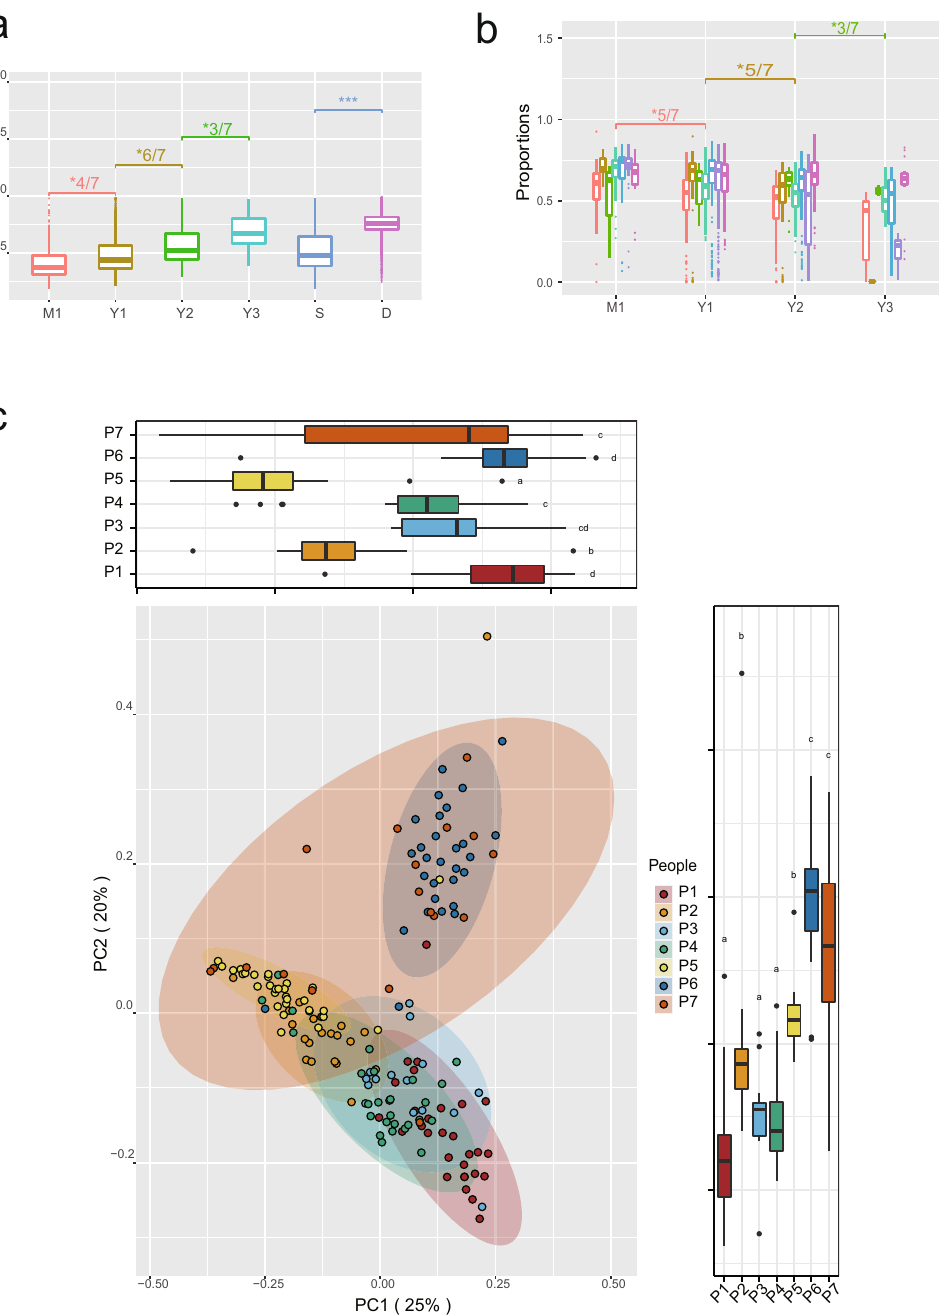
Fig. 2 Sample comparsions for gut microbiota composition. a Boxplots showing the Bray – Curtis dissimilarities between samples from four groups (M1/ Y1/Y2/Y3). M1 denotes comparisons from the same subject collected within a short time interval (1 month); Y1 and Y2 denote comparisons from the same subject collected within intermediate time intervals (Y1, 2 – 12 months; Y2, 13 – 24 months); and Y3 denotes comparisons from the same subject collected within a longer time interval (>24 months). S denotes comparisons from samples obtained within the same participant; D denotes comparisons between samples from different participants. P participant. *** p < 0.001; * 4/7: The signi fi cance ( p < 0.05) applies to 4 of 7 individuals; *6/7: The signi fi cance ( p < 0.05) appies to 6 of 7 individuals; *3/7: The signi fi cance ( p < 0.05) applies to 3 of 7 individuals. b Boxplots showing the proportions of source bacteria retained in a given microorganism community in the fecal samples. *5/7: The signi fi cance ( p < 0.05) applies to 5 of 7 individuals; *3/7: The signi fi cance ( p < 0.05) applies to 3 of 7 individuals. c PCoA diagram of samples from seven participants at the genus level. We uses the letters a , b and c to show statistically signi fi cant differences between groups. For all groups with the same letter, the difference between the means is not statistically signi fi cant. If two variables have different letters, they are signi fi cantly different. Boxplots display the distribution of data based on the fi ve number summary: minimum, fi rst quartile, median, third quartile, and